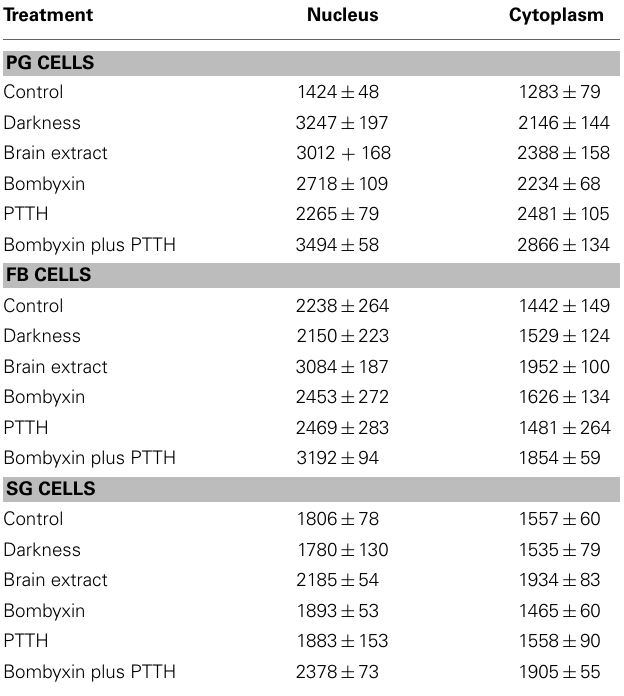
Table 4 | Mean relative PER fluorescence ± SEM in PG, FB and SG cells following various in vitro treatments.